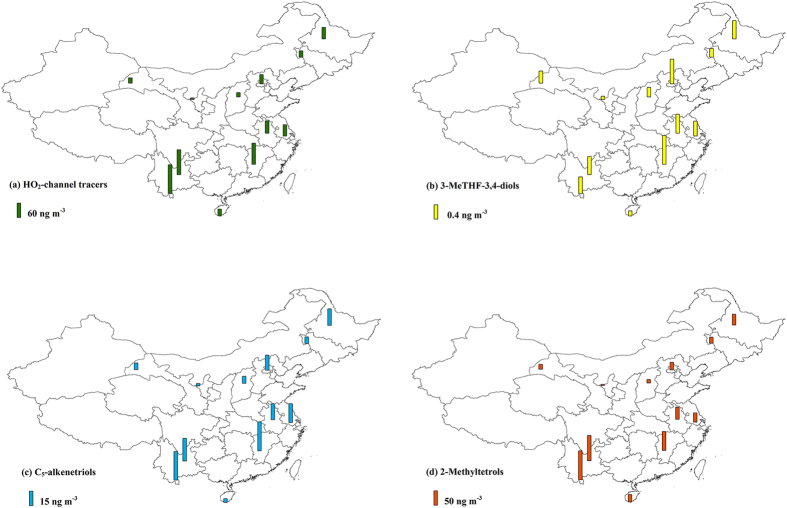
Spatial distribution of SOAI tracers formed from the HO2-channel.The bar represents the annual average at each site. The figure is created by ArcGIS 10.1.